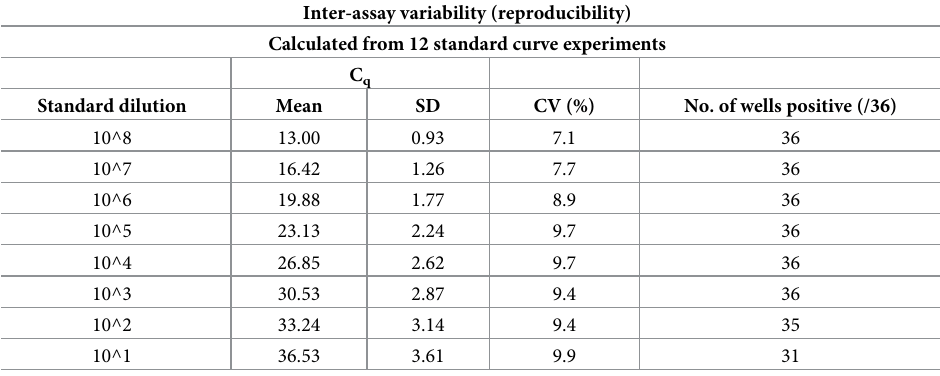
Table 5. Guinea worm qPCR inter-assay variability of standard curve dilution series (10 8 to 10 1 ) across 12 experi- ments (plates) at the University of Georgia. Nine experiments were conducted at the Southeastern Cooperative Wildlife Disease Study, and three were performed at other UGA